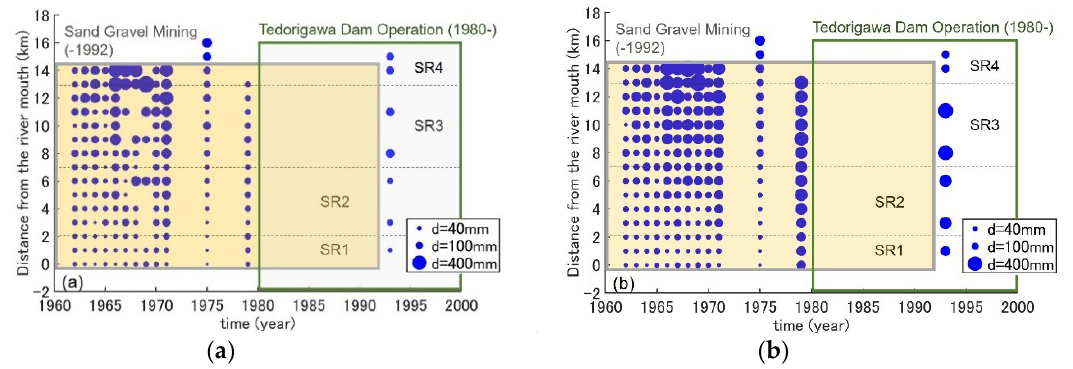
Figure 8. Temporal and spatial variations in sediment mean diameter in ( a ) main course and ( b ) lateral area.